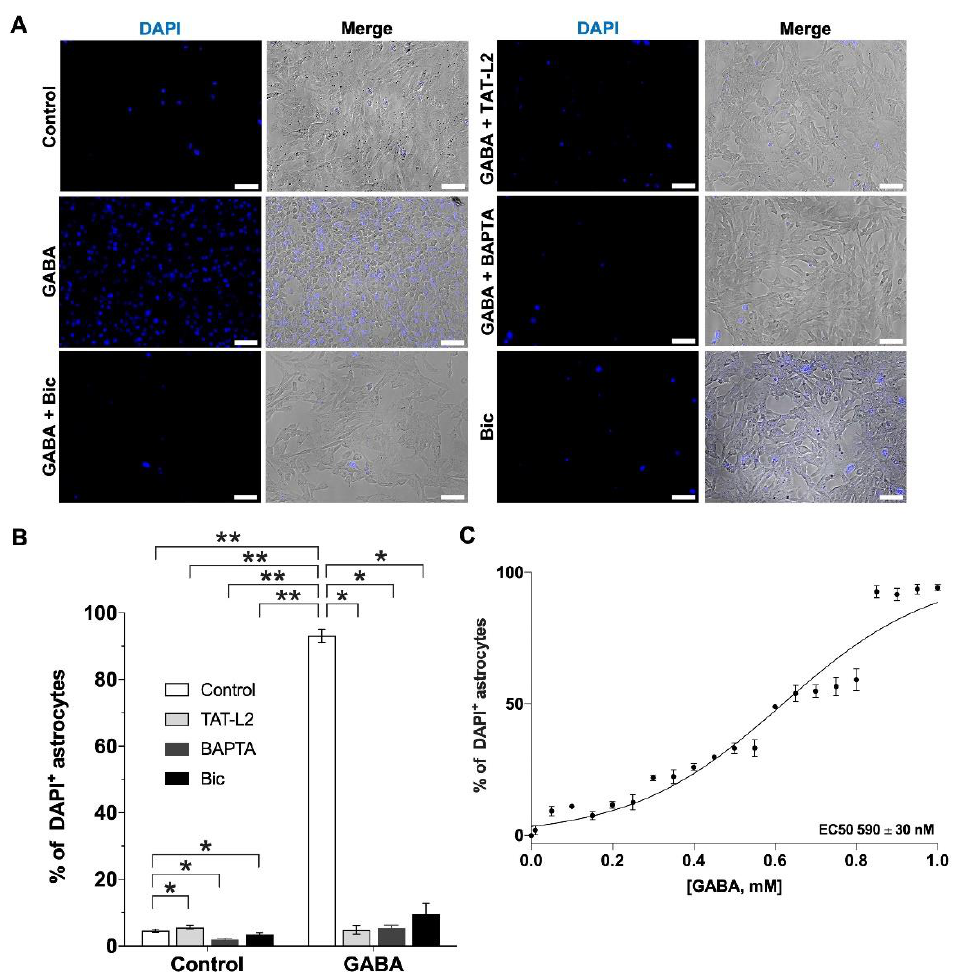
Figure 2. GABA increases DAPI uptake in DI TNC1 astrocytes through Cx43 hemichannels via activation of GABA A receptors. ( A ) Representative photomicrographs showing DAPI uptake in DI TNC1 astrocytes under normal extracellular Ca 2+ conditions (Control), show increased DAPI uptake in response to 1 µM GABA, effect that is prevented by preincubation with 100 µM bicuculline (Bic), 10 nM TAT-Cx43L2 (TAT-L2) or 100 nM BAPTA-AM (BAPTA). Scale bar: 50 µm. ( B ) Quantification of DAPI uptake. n = 3, with technical triplicates. ( C ) Concentration response curve for GABA on astroglial DAPI uptake performed to estimate the EC50 for GABA (EC50: 590 ± 30 nM). Error bars: SE; * p ˂ 0.05, ** p ˂ 0.01.